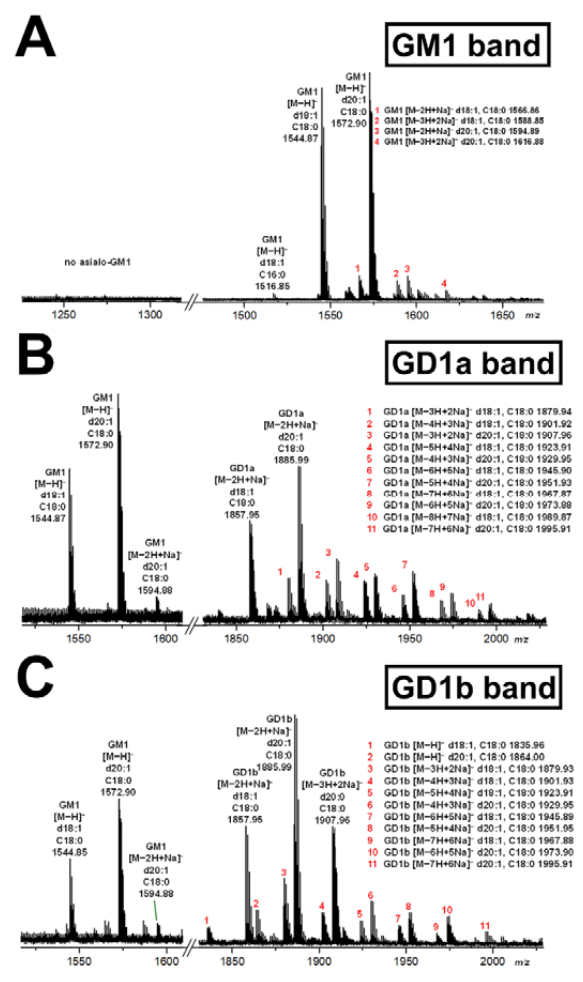
Figure 3. MS 1 spectra of choleragenoid-detected GM1 species of reference human brain gangliosides at TLC positions of GM1 ( A ), GD1a ( B ) and GD1b ( C ) after treatment with neuraminidase of Vibrio cholerae . Separated gangliosides were extracted after V. cholerae neuraminidase treatment from scraped silica gel at positions of the TLC bands of GM1, GD1a and GT1b, which are marked by red arrows in Figure 2A. Spectra were recorded in the negative ion mode. The major signals of the deprotonated [M − H] − species of GM1 and the deprotonated sodium adducts [M − 2H+Na] − of GD1a and the [M − 2H+Na] − and [M − 3H+2Na] − adducts of GD1b are listed in Table 1. Numbered minor species of GM1 ( A ) and the “precursor” disialogangliosides GD1a ( B ) and GD1b ( C ) are depicted on the right sides of the